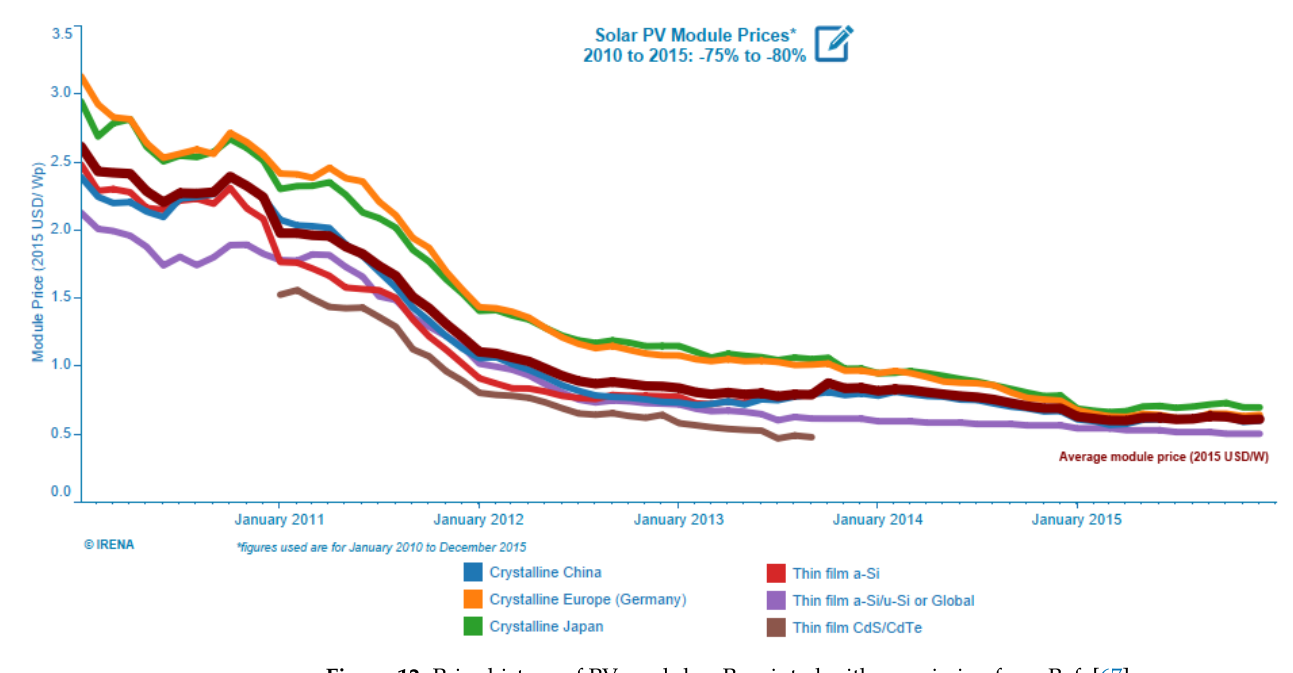
Figure 12. Price history of PV modules. Reprinted with permission from Ref. [67].